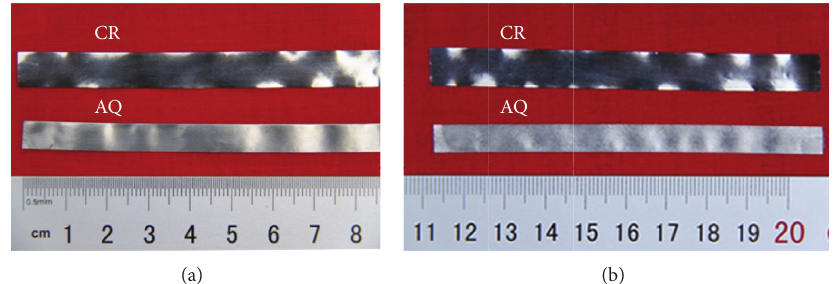
Figure 5: Rapidly quenched ribbons with and without cold rolling of 33% reduction: (a) surface contacting the single-roller and (b) free surface of the ribbon. AQ: as-quenched, CR: cold